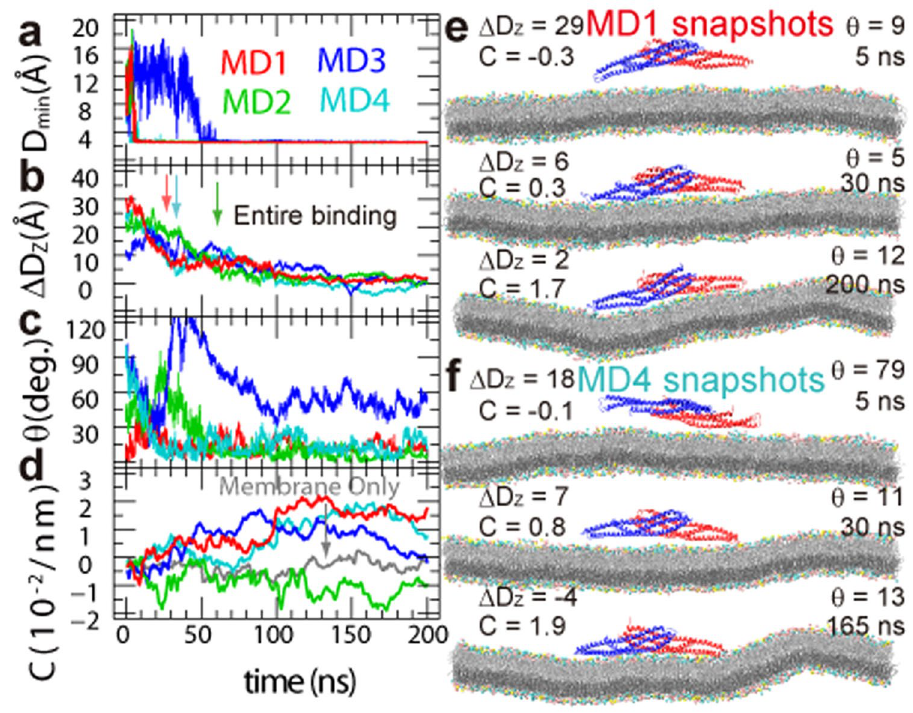
Figure 2. Time evolution of I-BAR binding to the lipid bilayer membrane. ( a ) Minimum heavy atom pair distance between the I-BAR domain and the membrane, ( b ) I-BAR–membrane distance Δ D Z , ( c ) angle θ , and ( d ) curvature C ave as a function of MD simulation time. ( e,f ) representative snapshots from ( e ) MD1 and ( f ) MD4. The molecular graphics was created by VMD 57